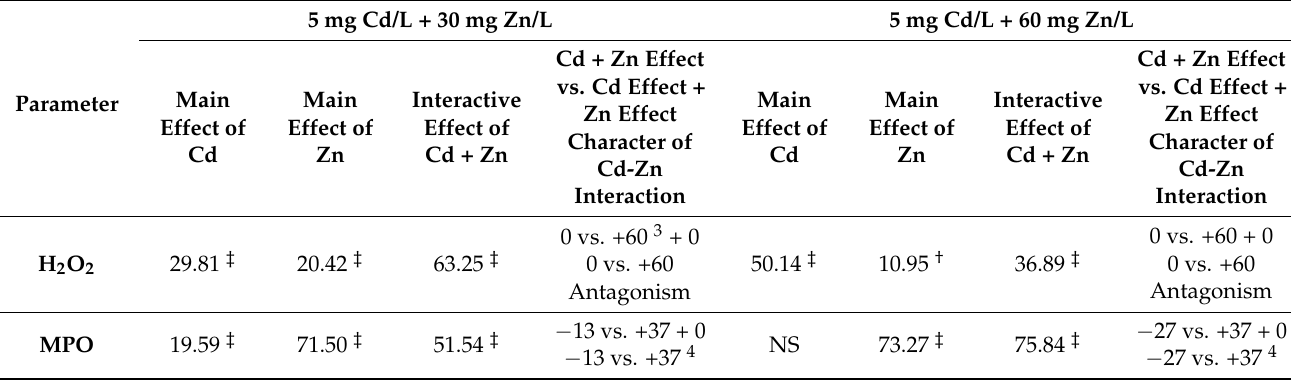
Table 4. Interactive and main effects of cadmium (Cd) and zinc (Zn) on the concentrations of hydrogen peroxide (H 2 O 2 ) and myeloperoxidase (MPO) in the brain tissue of male rats 1,2 .